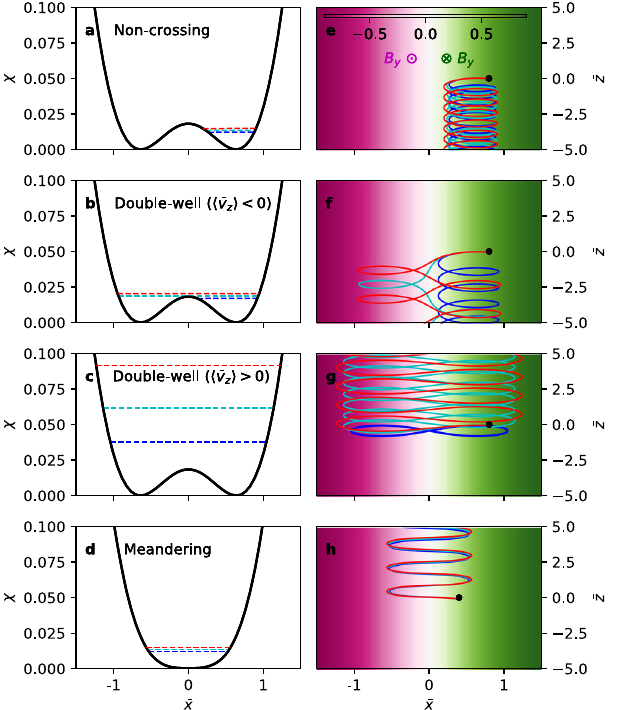
Fig. 1 Four classes of particle orbits and their effective potentials. Effective potentials χ of the a non-crossing (NC) orbit class, b double-well (cid:11) (cid:12) < 0; DW − ), c double- orbit class with a negative time-averaged velocity ( (cid:2) v z (cid:11) (cid:12) > 0; DW + ), and well orbit class with a positive time-averaged velocity ( (cid:2) v z d meandering (M) orbit class. e – h Particle orbits in the (cid:2) x (cid:2) (cid:2) z plane Fig. 2 Particle distribution in phase space, velocity space, and physical respectively belong to the four classes in a – d . The strength of the out-of-plane space. Phase-space distributions of the four orbit classes distinguished by magnetic fi eld B y is represented by the magenta and green colors. Three the blue, green, red, and black colors in a (cid:2) x (cid:2) (cid:2) v x space, b (cid:2) x (cid:2) (cid:2) v y space, and c (cid:2) x (cid:2) (cid:2) v (cid:2) v (cid:2) v (cid:2) v particles are plotted for each class and are labeled by the blue, cyan, and red z space. Particle histograms in d x , e y , and f z . The dotted lines and colors. Each particle ’ s energy is represented by its corresponding color in a – d . arrows are, respectively, the average velocities and two standard deviations The blue particles in f and g , respectively, belong to NC and DW − but are of each distribution. g Particle histogram in (cid:2) x plotted to show the NC → DW − and DW − → DW + transitions. and the three dashed lines in each panel represent the energies of (cid:2) H . three particles with differing values of initial (cid:2) v x and thus of Each particle is distinguished by its respective color (blue, red, or cyan). The three lines in Fig. 1e – h show the motion of the three particles in the left panels in the x − z plane, and the black dots represent their starting positions. Figure 1e represents the non-crossing orbit class 38 , hereafter denoted NC, where the particles are simply ∇ B drifting with h (cid:2) v i < 0. Figure 1f represents the class where particles undergo full z double-well motion with h (cid:2) v z i < 0, hereafter denoted DW − . The blue particle in Fig. 1f belongs to NC but is plotted to show the transition from NC to DW − . Figure 1g represents the other class where h (cid:2) v z i > 0, hereafter denoted DW + . Again, the blue particle belongs to the DW − class but is plotted to show the transition from DW − to DW + . Figure 1h represents the meandering or Speiser orbit class 39 with h (cid:2) v z i > 0, hereafter denoted M. The DW + class was previously identi fi ed in a context with curved magnetic fi elds as “ cucumber orbits 40,41 ” owing to its cucumber shape. Here, we have re-identi fi ed the class to clarify the physical origin of such motion and to distinguish more clearly between DW + and DW − , the latter of which does not exhibit cucumber shapes.